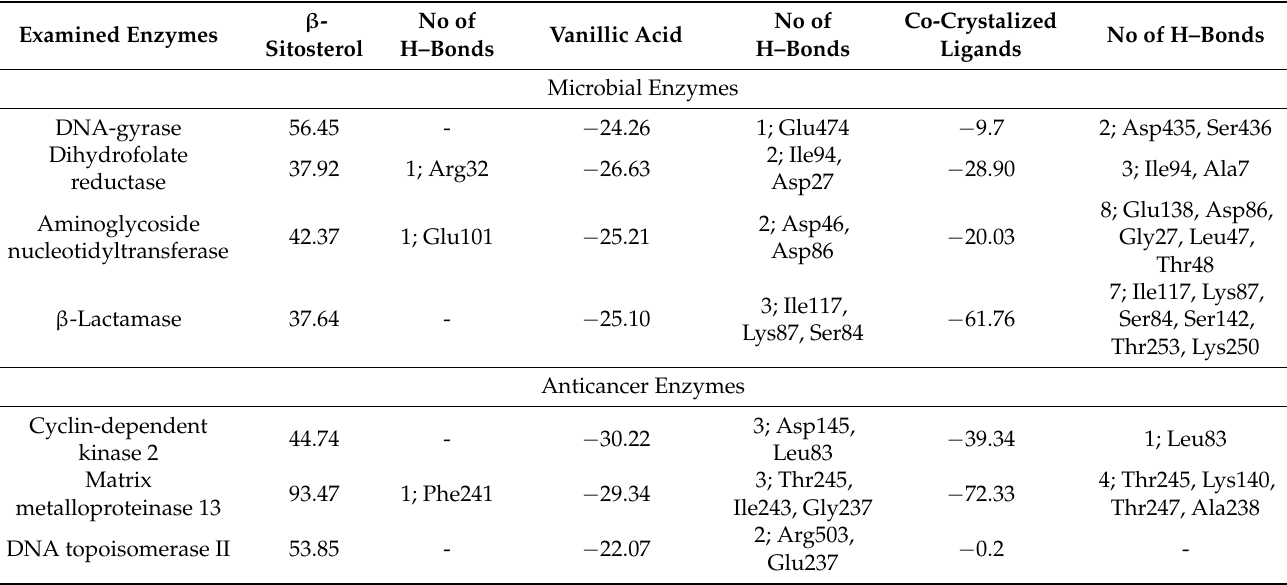
Table 3. Binding energies (kcal/mole) of β -sitosterol ( 1 ) and vanillic acid ( 2 ) isolated from D. bupleuroides within the active sites of crucial microbial and cancer triggering